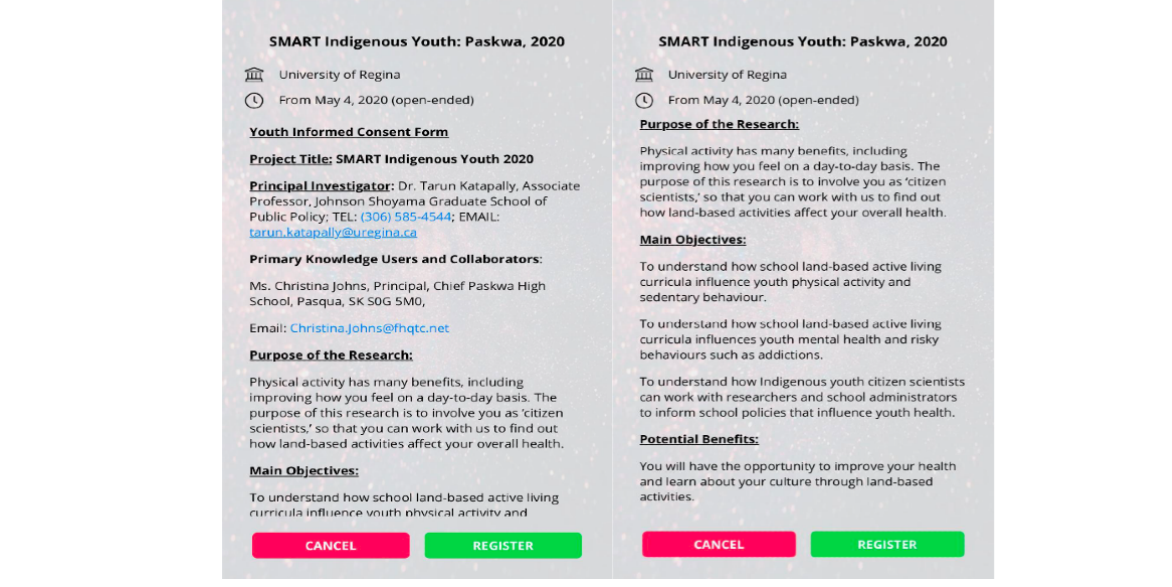
Figure 3. Study dropout option for citizen